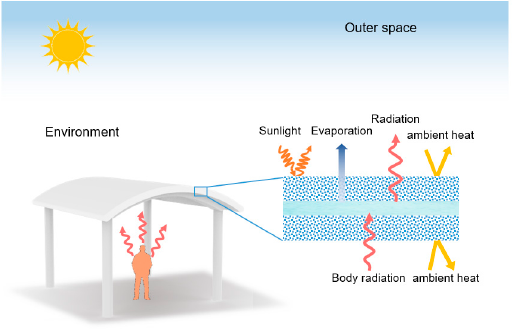
Figure 1. Schematic of the proposed triple-layered membrane.